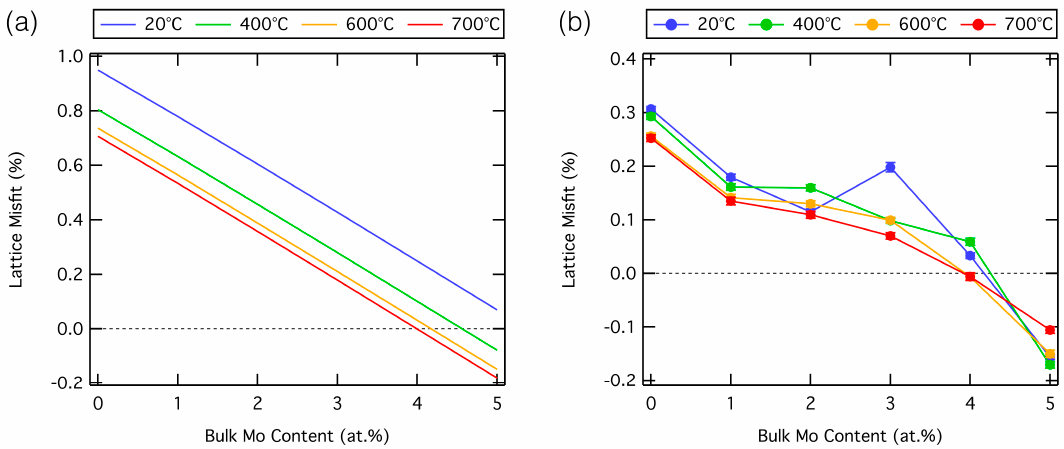
Figure 4. Lattice misfit as a function of nominal bulk Mo content, ( a ) predicted by ThermoCalc and ( b ) experimentally measured by neutron diffraction.